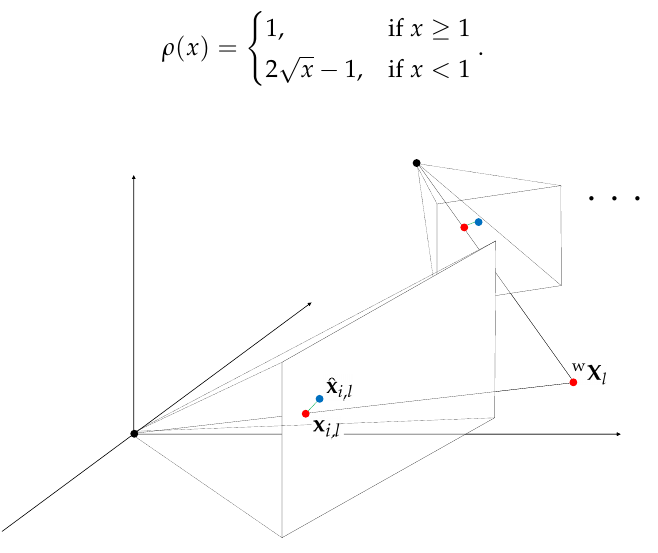
Figure 3. Illustration of the visual error. The green dashed line represents re-projection error e ν , and the visual error term optimizes the summation of these errors for the local